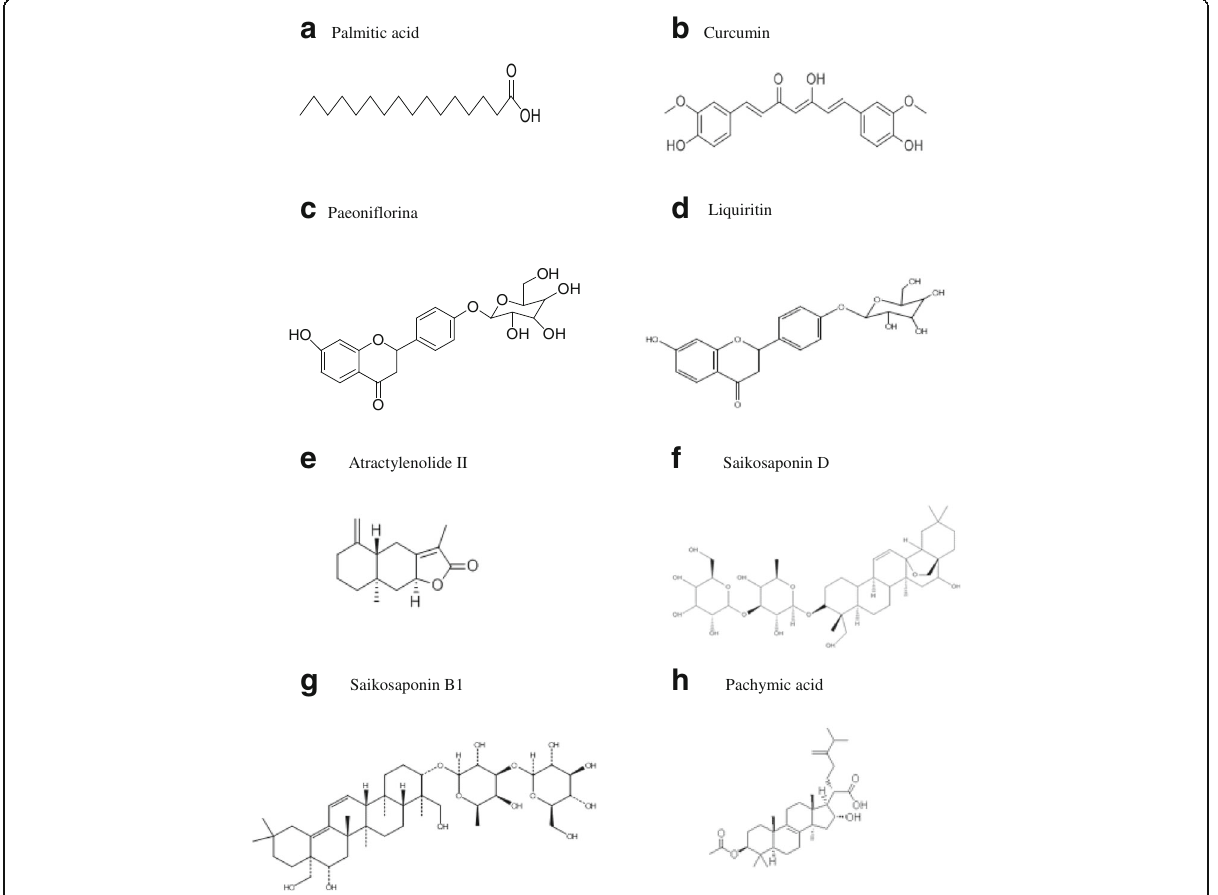
Fig. 1 Molecular structures of eight ingredients in XYS sample. a Palmitic acid. b Curcumin. c Paeoniflorin. d Liquiritin. e Atractylenolide II. f Saikosaponin D. g Saikosaponin B1. h Pachymic